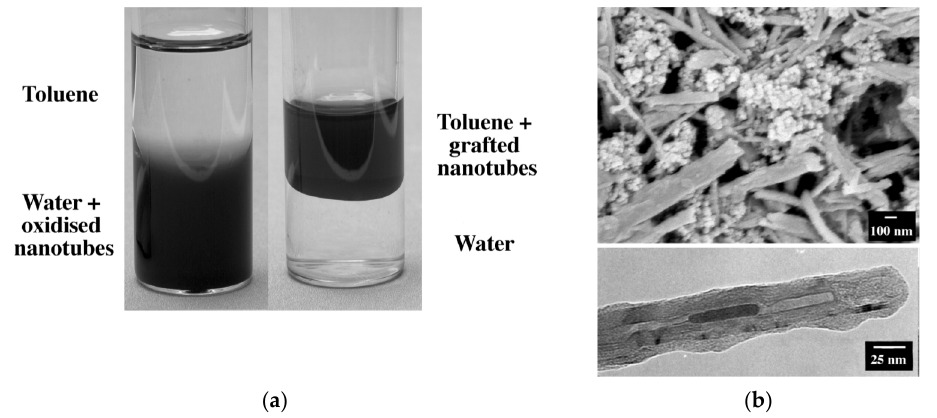
Figure 1. ( a ) Solubility of nanotubes in different environments. ( b ) SEM (top) of partially purified grafted nanotubes (the polymer aggregates disappeared after further purification) and TEM (bottom) results of a single grafted nanotube. With permission [24].